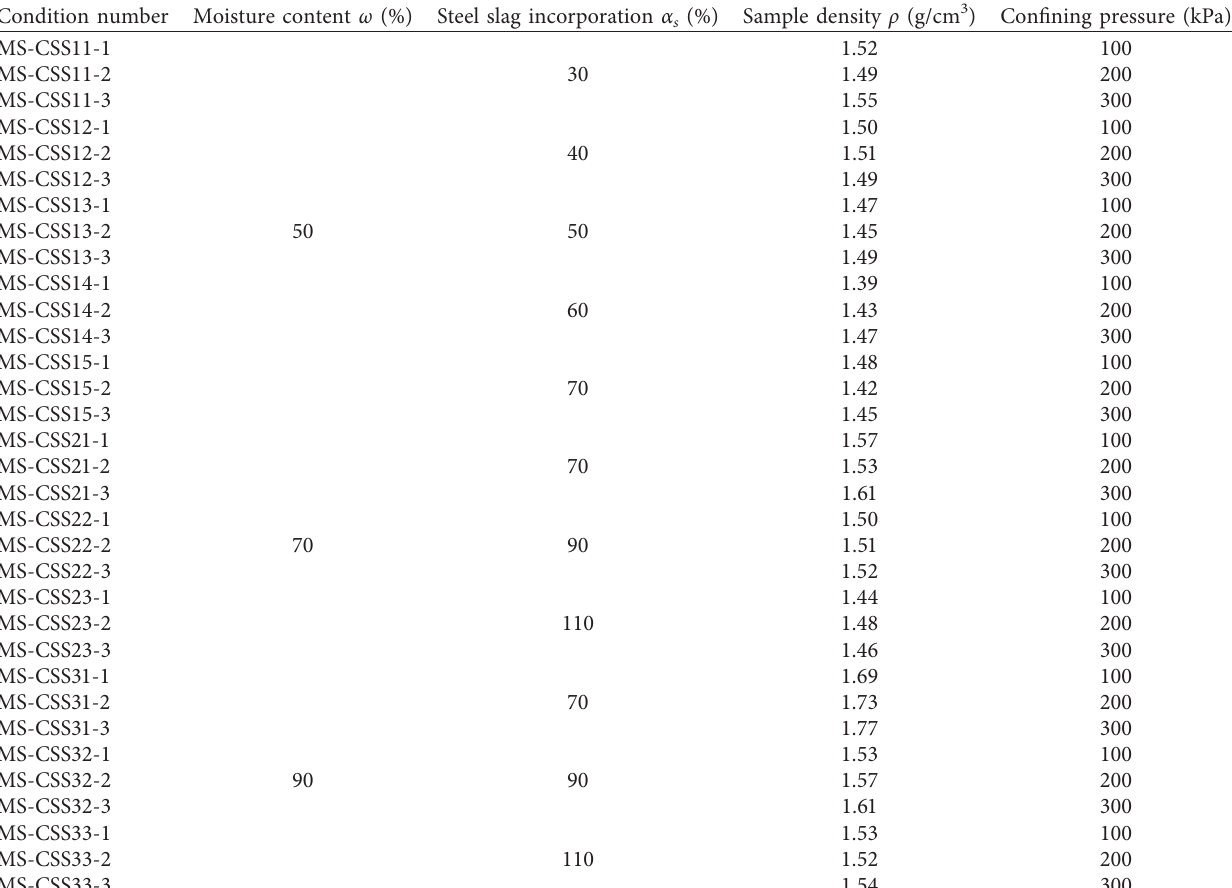
Table 3: Triaxial test specific working conditions’ table.